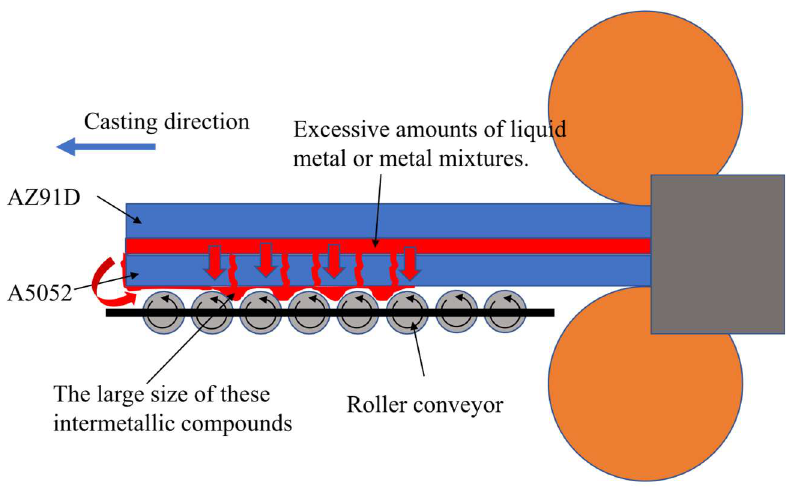
Figure 6. Schematic diagram of intermetallic compound output.